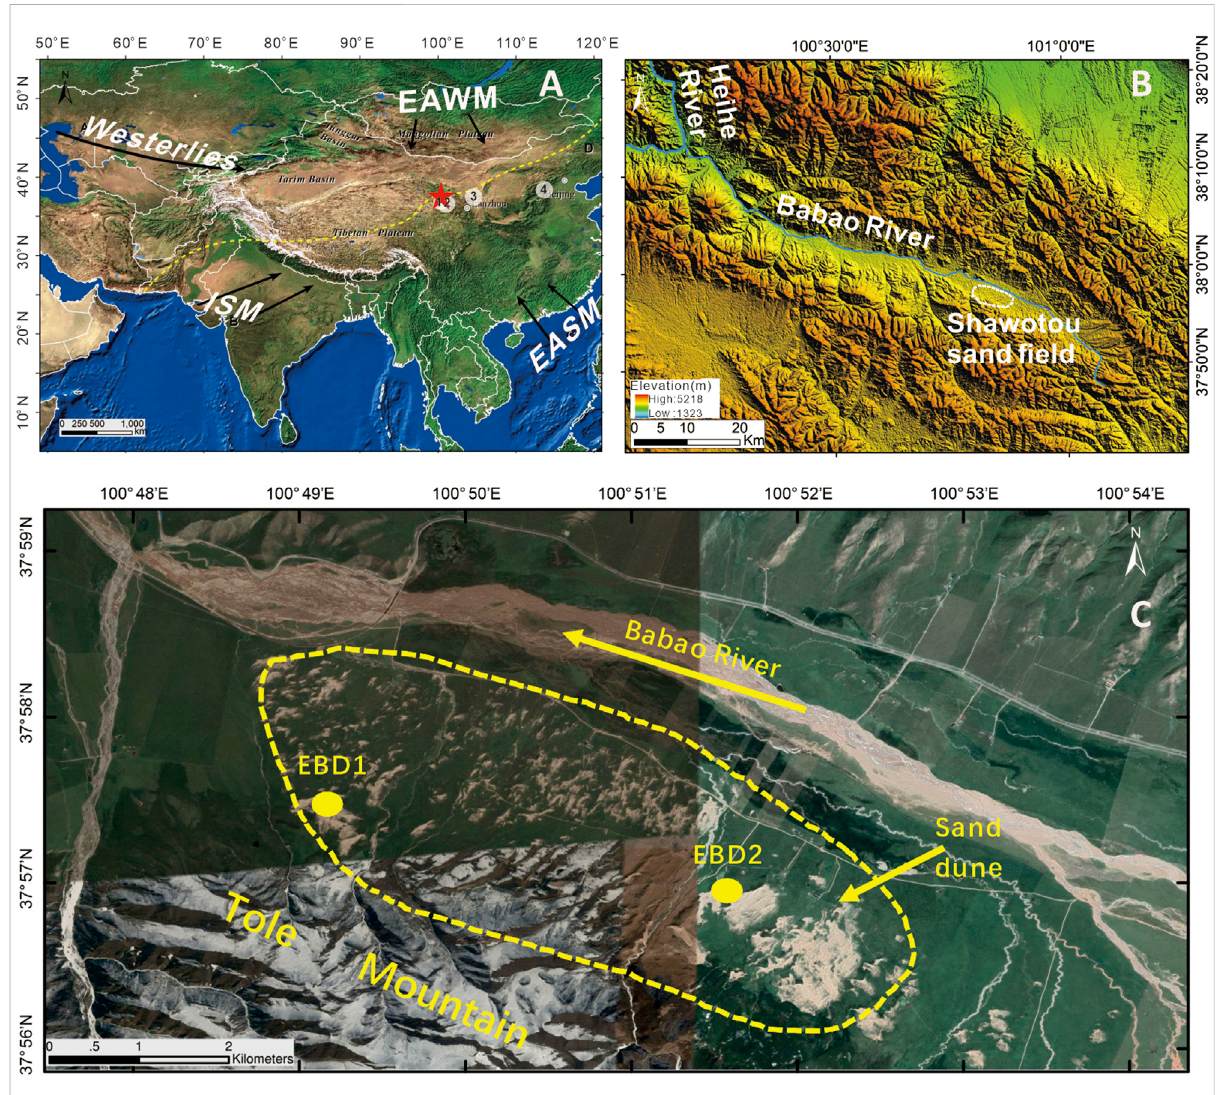
FIGURE 1 (A) Locationofthestudyarea(redstar)andthemainatmosphericcirculationsystemsin fl uencingthearea,suchaswesterlies,EASM,andEAWM. The fi gures denote the paleoclimate records discussed in the text: ① Qinghai Lake (Li et al., 2017), ② Dalianhai in Gonghe basin (Cheng et al., 2013), ③ Baijian Lake basin (Long et al., 2012), and ④ Gonghai Lake (Chen et al., 2015); (B) DEM of the Babao River drainage area in southeast Qilian Mountains; locality of the Shawotou sand fi eld near Ebao Town is outlined; (C) the satellite image of the Shawotou sand fi eld and solid yellow dots are the sites of two